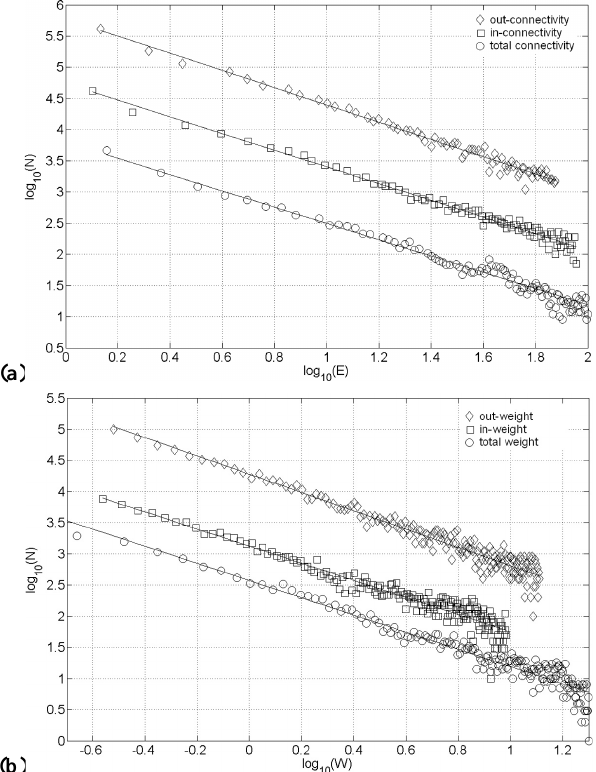
Fig. 8. Connectivity and weight distributions for network M1. The curves are shifted by 10 units each along the Y axis. (a) Total con- nectivity (circles), in-connectivity (squares), out-connectivity (dia- monds). N is the number of nodes that have a number of edges E (on the X axis). (b) Total weight (circles), in-weight (squares), out- weight (diamonds). N is the number of nodes that have a weight of W (on the X axis).